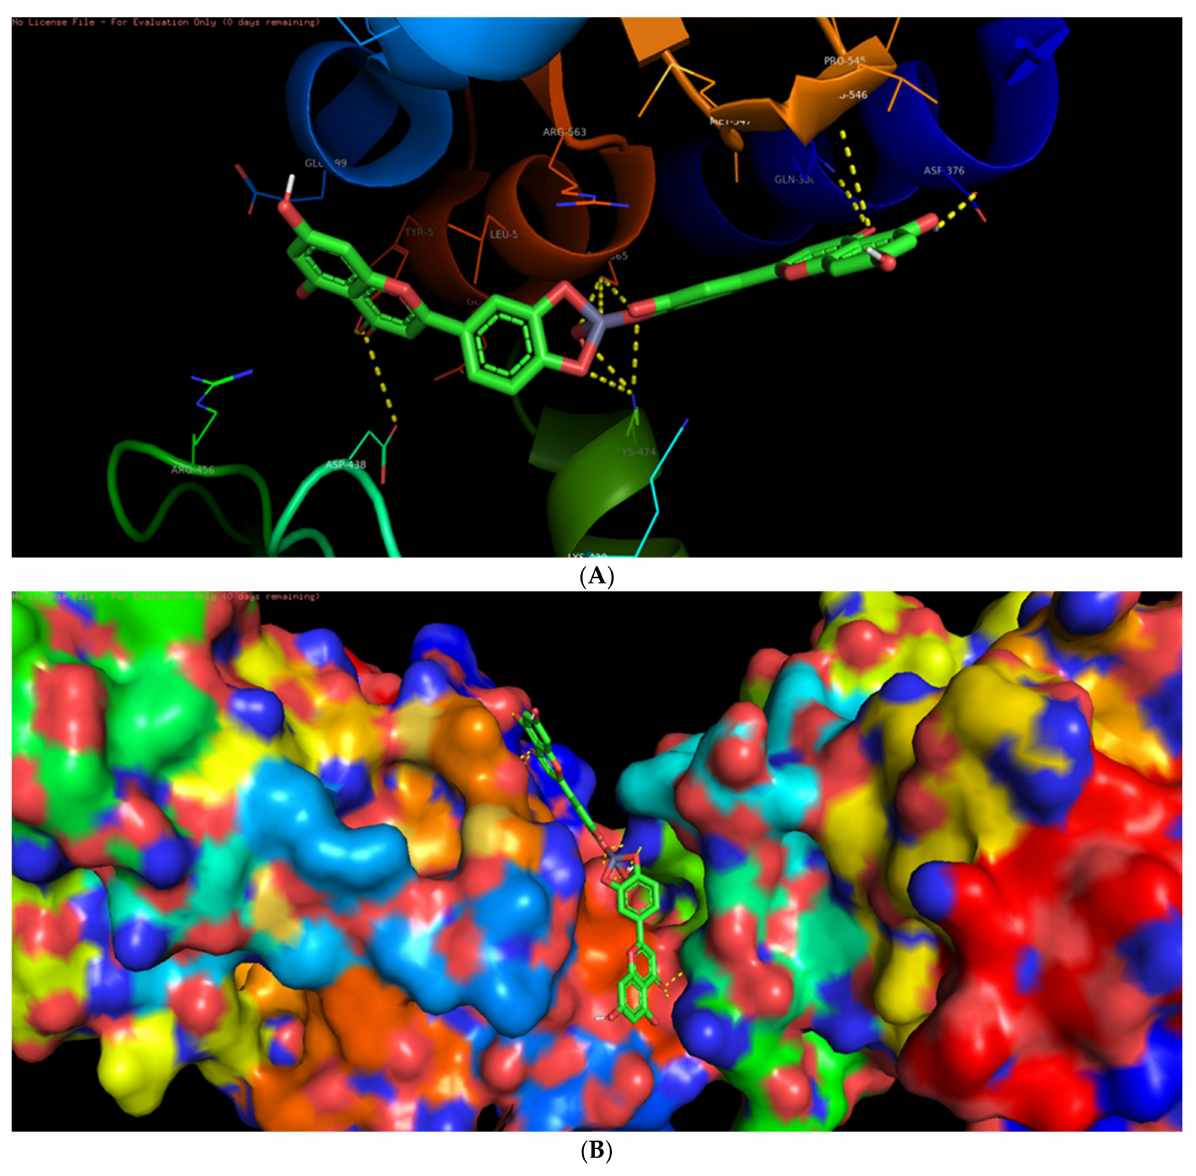
Figure 9. ( A ) The bonded and non-bonded interactions of L-ZnONPs with the cancer protein 1Q4O. ( B ) The best-docked pose of L-ZnONPs bound to the hydrophobic preset of the 1Q4O